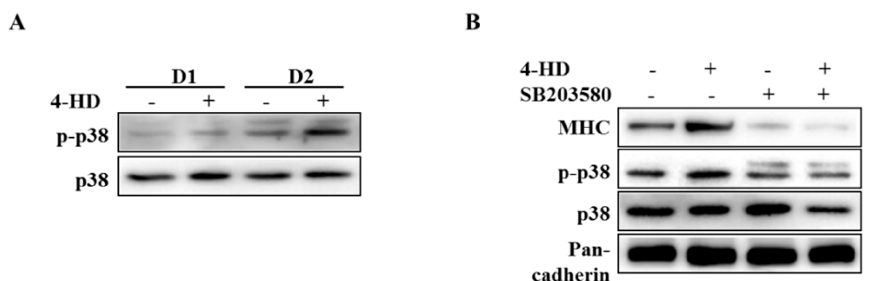
Figure 4. Effect of 4-HD on p38 MAPK activation during myogenesis. ( A ) 4-HD (100 pM) treated myoblasts were harvested at indicated differentiation periods. ( B ) Confluent myoblasts were pre-incubated with SB203580 (10 µ m) for 1 h, followed by 4-HD stimulation for 2 days. The phospho-p38 MAPK was measured by Western blotting analysis.